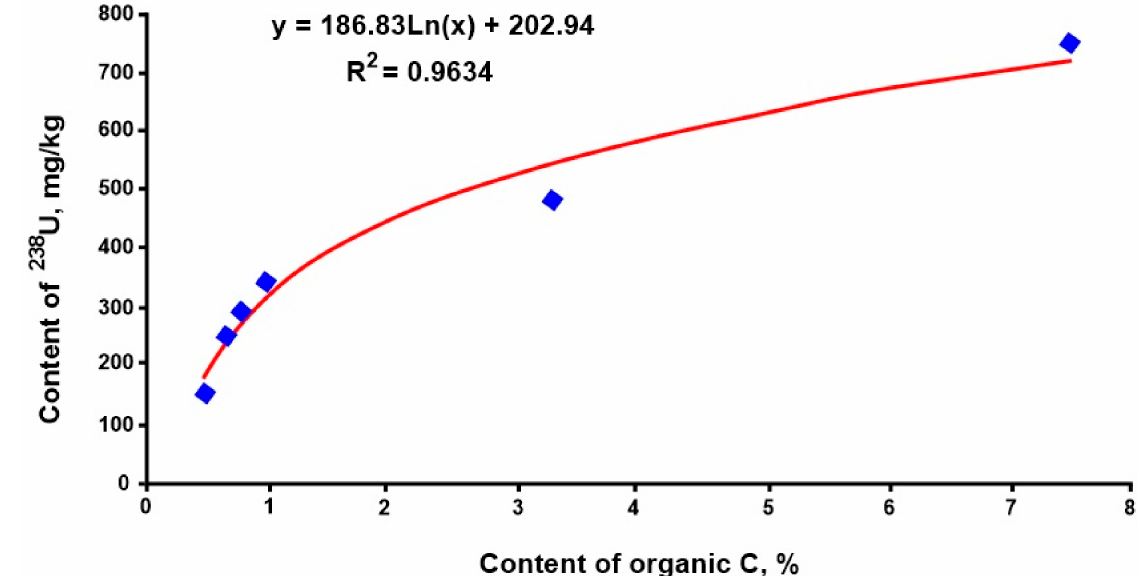
Figure 4. Relationship between the content of 238 U (y-axis) and organic carbon (x-axis) in bottom silt deposits of Propa- dayushiy Creek.